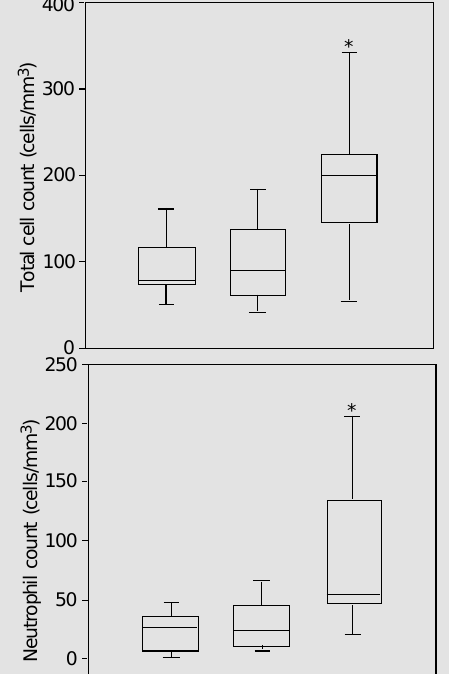
Figure 2. Total cell and neutro- phil counts and the percentage of baseline in the three groups. After 4 h, total cell count, neu- trophil count and its percentage of baseline were higher in group 3 compared with groups 1 and 2. *P<0.05 (one-way rank analy- sis of variance).